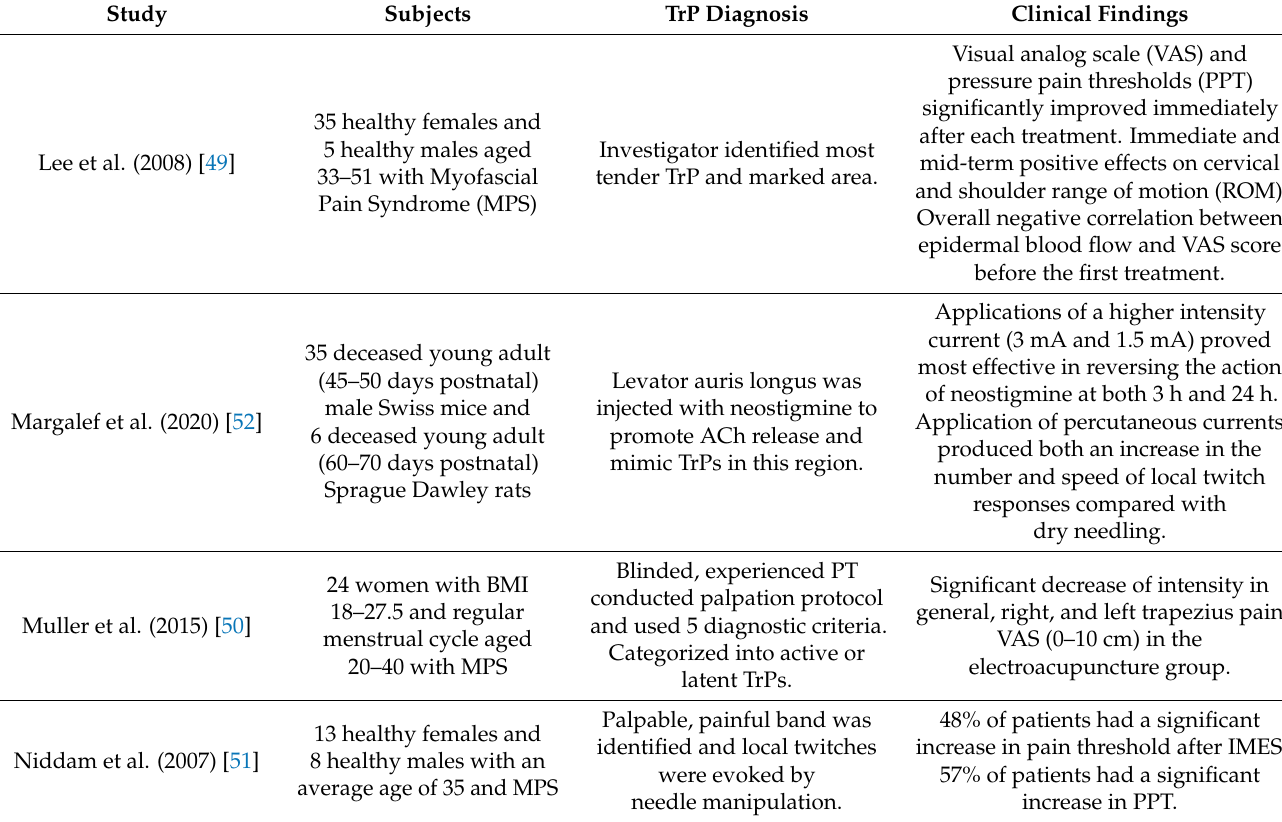
Table 3. Description of clinical findings from included